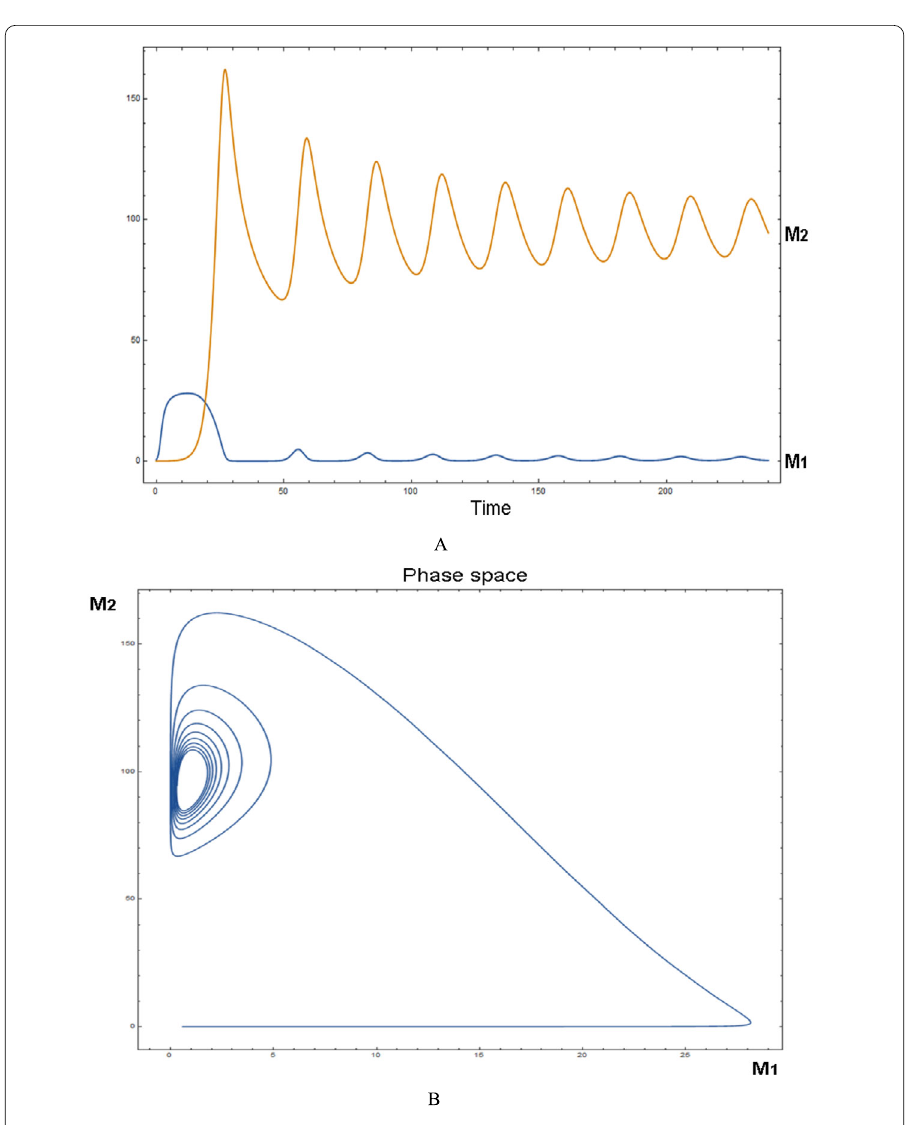
Figure 7 Time series showing the existence of periodic solutions at the neighborhood of the steady state equilibrium giving birth to a stable limit cycle in A and the phase portrait in B for M 1 (0) = 0.6, M 2 (0) = 0.02, a 1 = 0.07, b 1 = 0.039, V = 30, a 2 = 0.023, b 2 = 0.06, a 3 = 0.13, n = 0.99999, m =